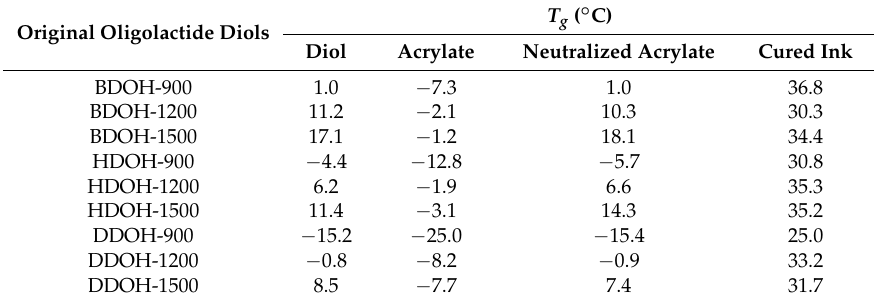
Table 5. Glass transition temperatures of OL-OHs, OL-As, neutralized OL-As, and cured inks.